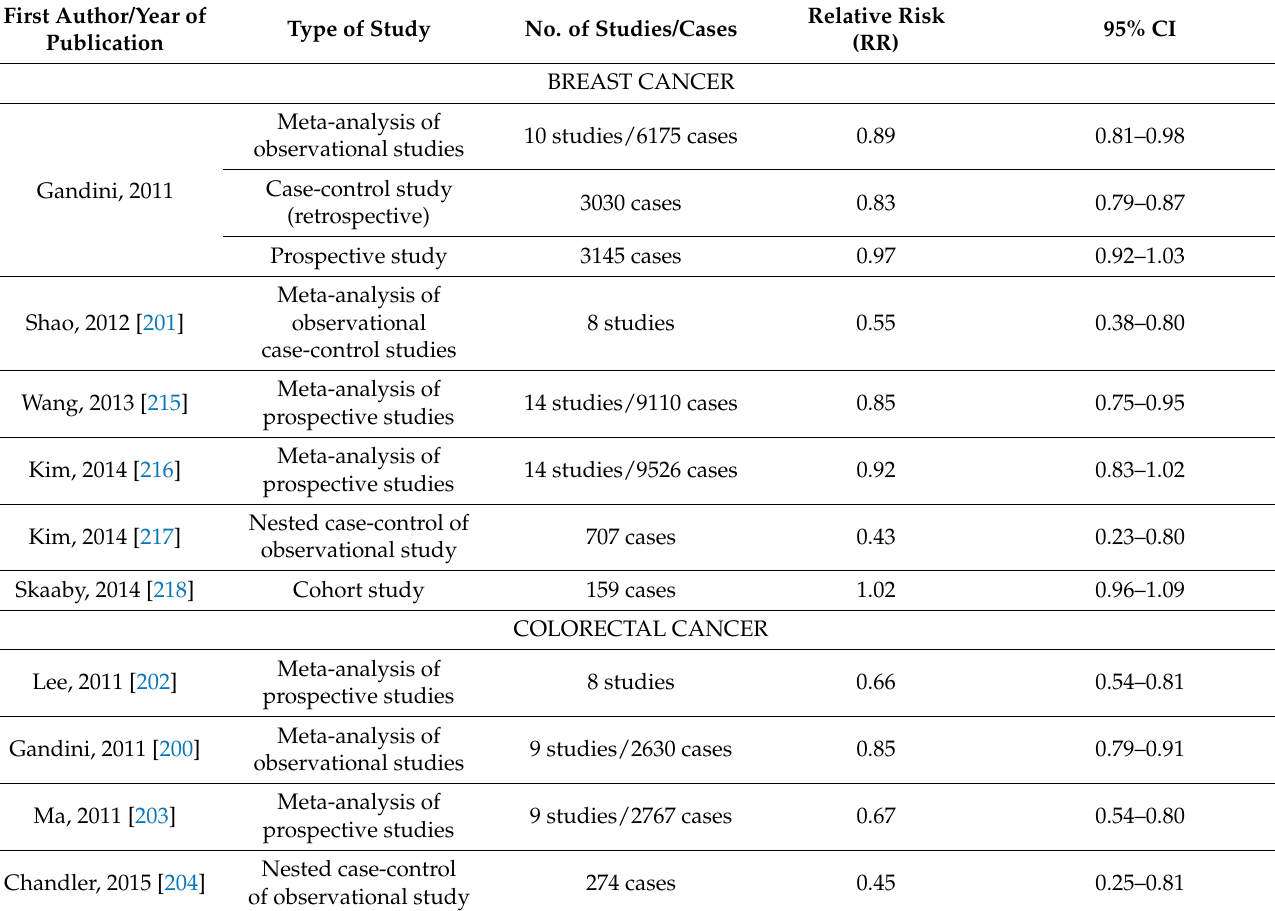
Table 1. Studies of blood 25(OH)D concentrations and cancer